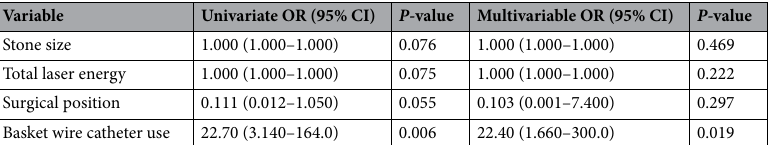
Table 3. Logistic regression analysis of factors associated with overall scope damage. OR odds ratio, CI confidence